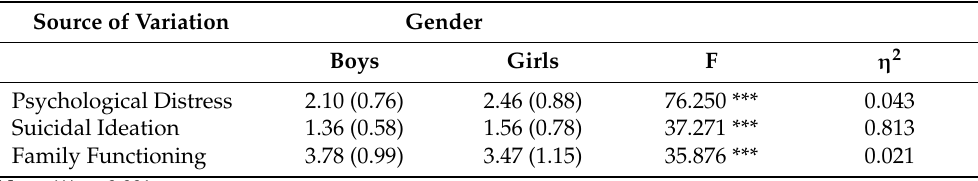
Table 5. ANOVAS in function of gender.